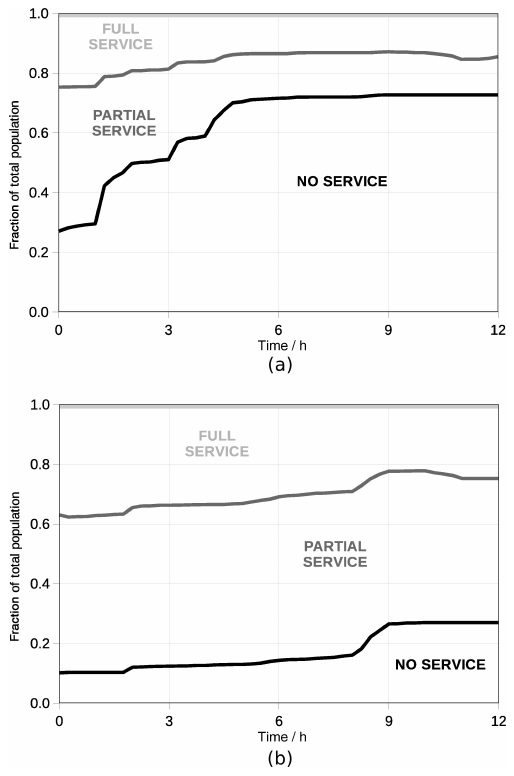
Figure 5. P NS as a fraction of total population in failure sce- nario 1 (a) and failure scenario 2 (b) .